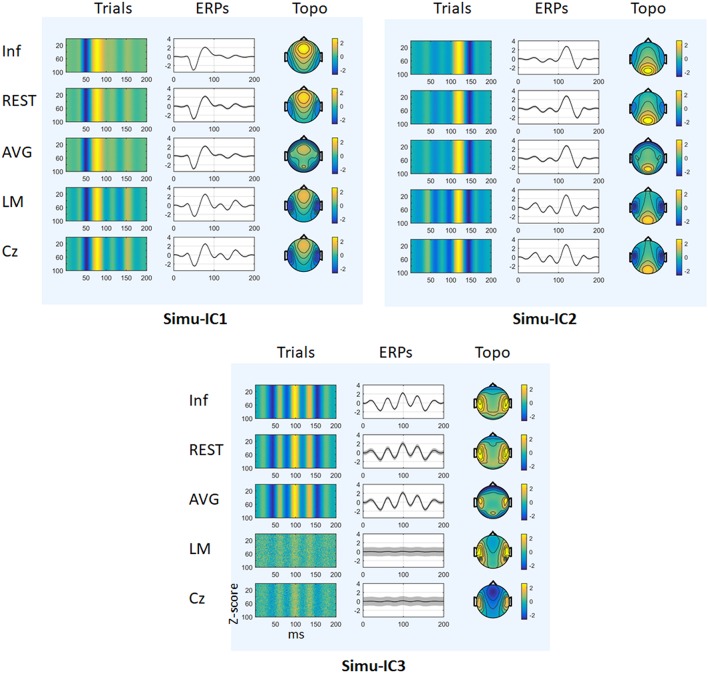
Results of simulation (SNR = 1). The mean trials, ERPs and topographic maps of each ICA component (Simulation IC1–IC3) for the Inf, REST, AVG, LM, and Cz references are shown separately. The gray region in ERPs represents standard deviations across 100 repeats.